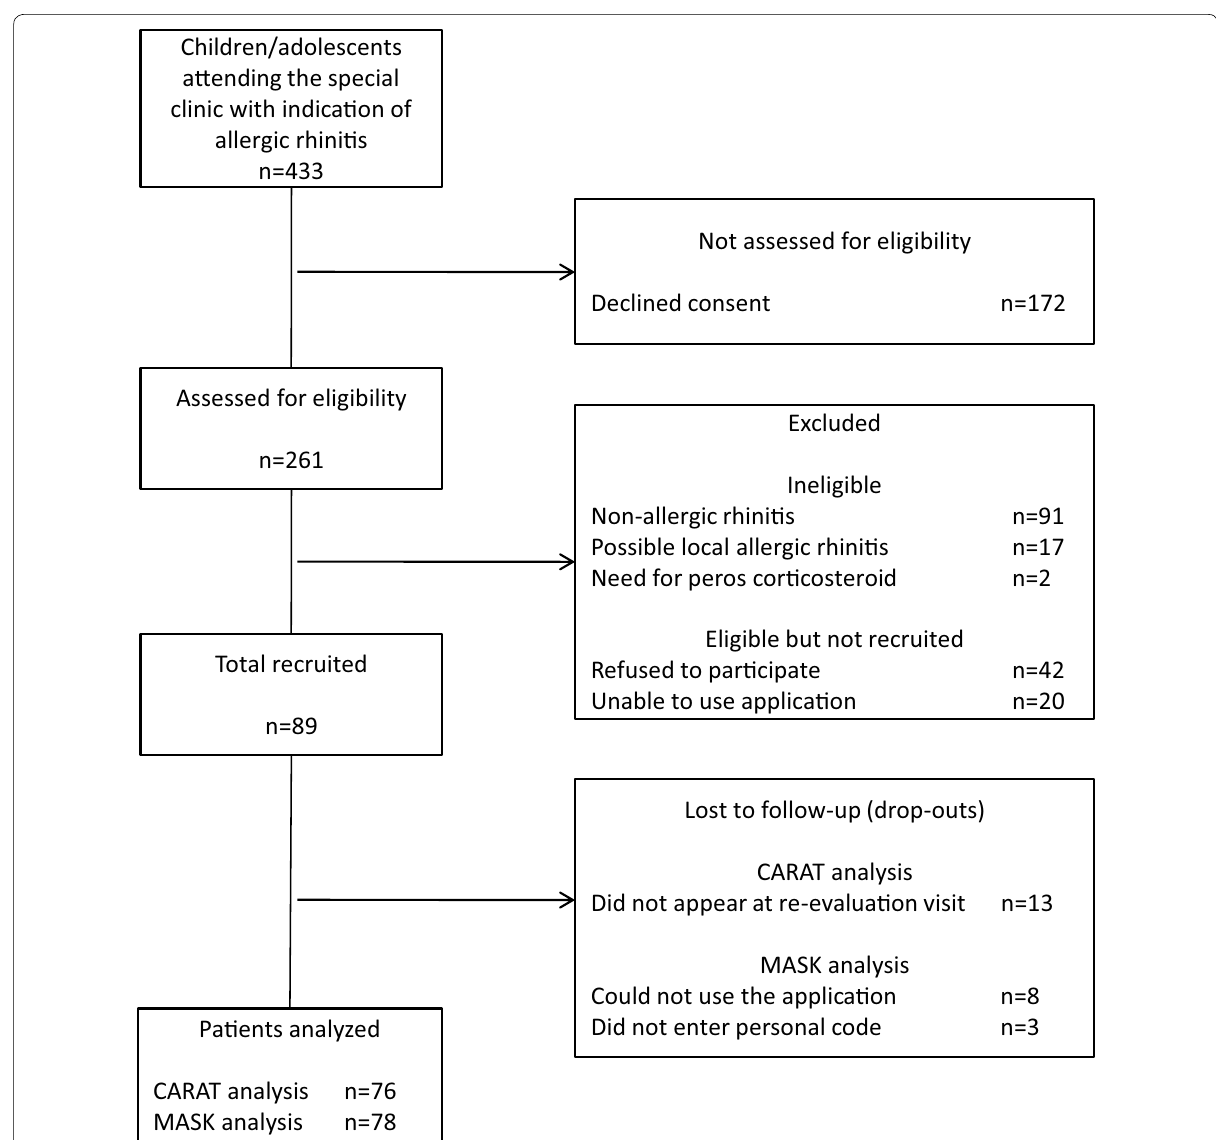
Fig. 1 Flow chart of the selection process of included